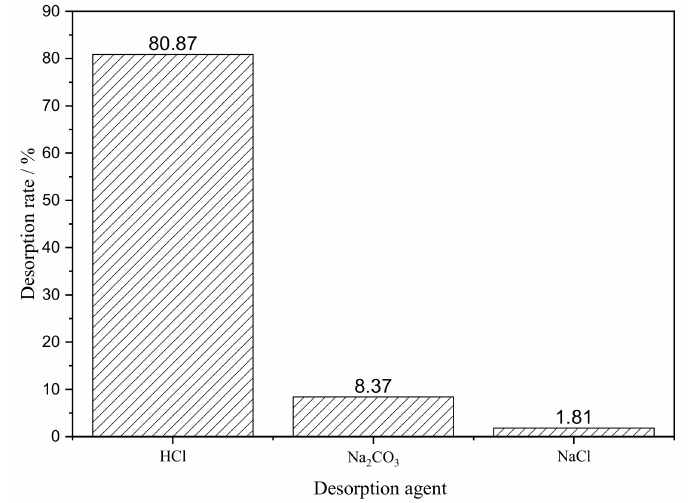
Figure 14. Screening of desorption agent for